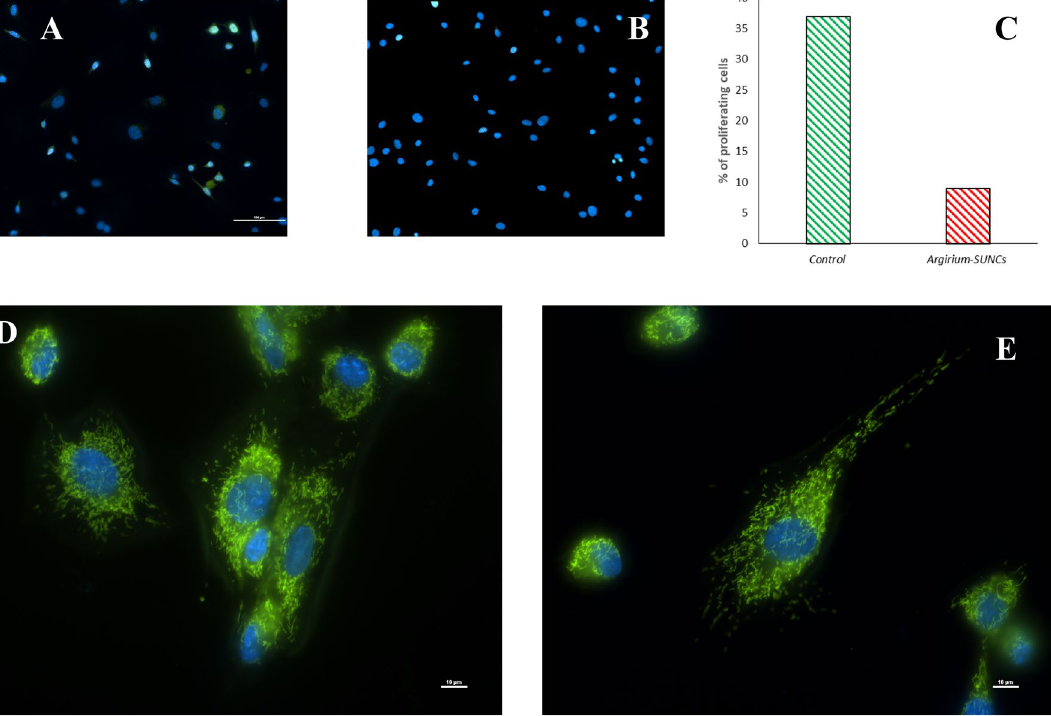
Figure 6. Effect of Argirium-SUNCs on fibroblasts. ( A , B ) The BrdU assay revealed that Argirium-SUNCs reduced cell proliferation ( B ) in SAF compared to control ( B ). The difference in the proliferating cells (%) is reported in histogram ( C ). The images show BrdU positive cells (green), indicative of replicating cells. All nuclei were counterstained with Hoechst 33342 (blue). Merge means Hoechst + BrdU ( A , B ) (n = 3 images) (* p < 0.0005; C ) . Scale bar = 100 μm; magnification is 20X ( D , E ) Sheep fibroblasts, that were previously subjected to Arg- SUNCs treatment for 24 h ( D ) and control non-treated ( E ), were stained with Mitotracker green dye.